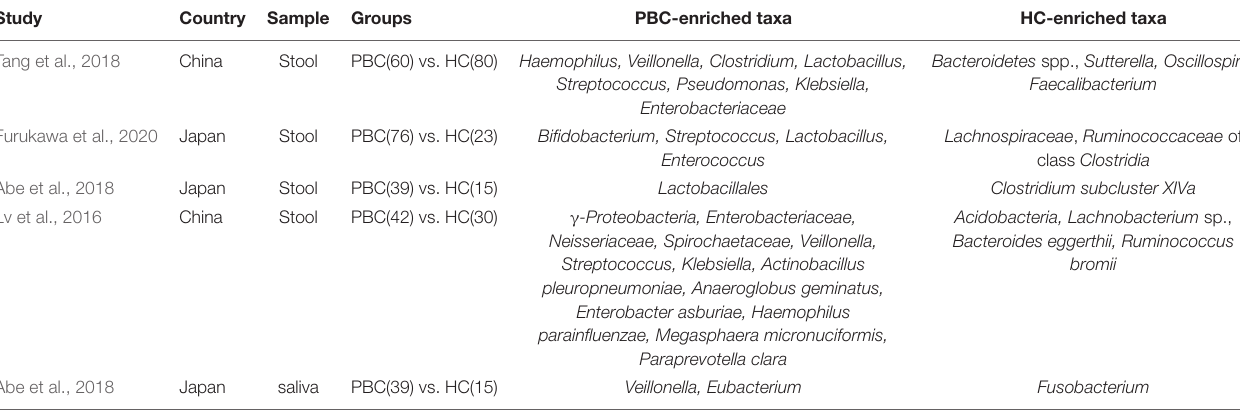
TABLE 3 | Study of the microbiome in primary biliary cholangitis